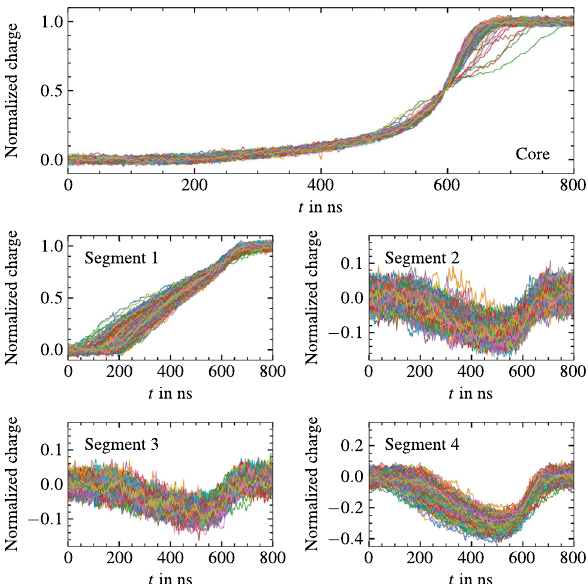
Fig. 12 Individual pulses from events assigned to the interaction point at r = 33 . 5mm, φ = 46 . 1 ◦ and a reconstructed z = ( 20 ± 1 ) mm, with one hit in the pixelated camera from a 10min Compton Scanner measurement at a detector temperature of 85K. All pulses are time- shifted such that the core pulses are aligned to 50% of their